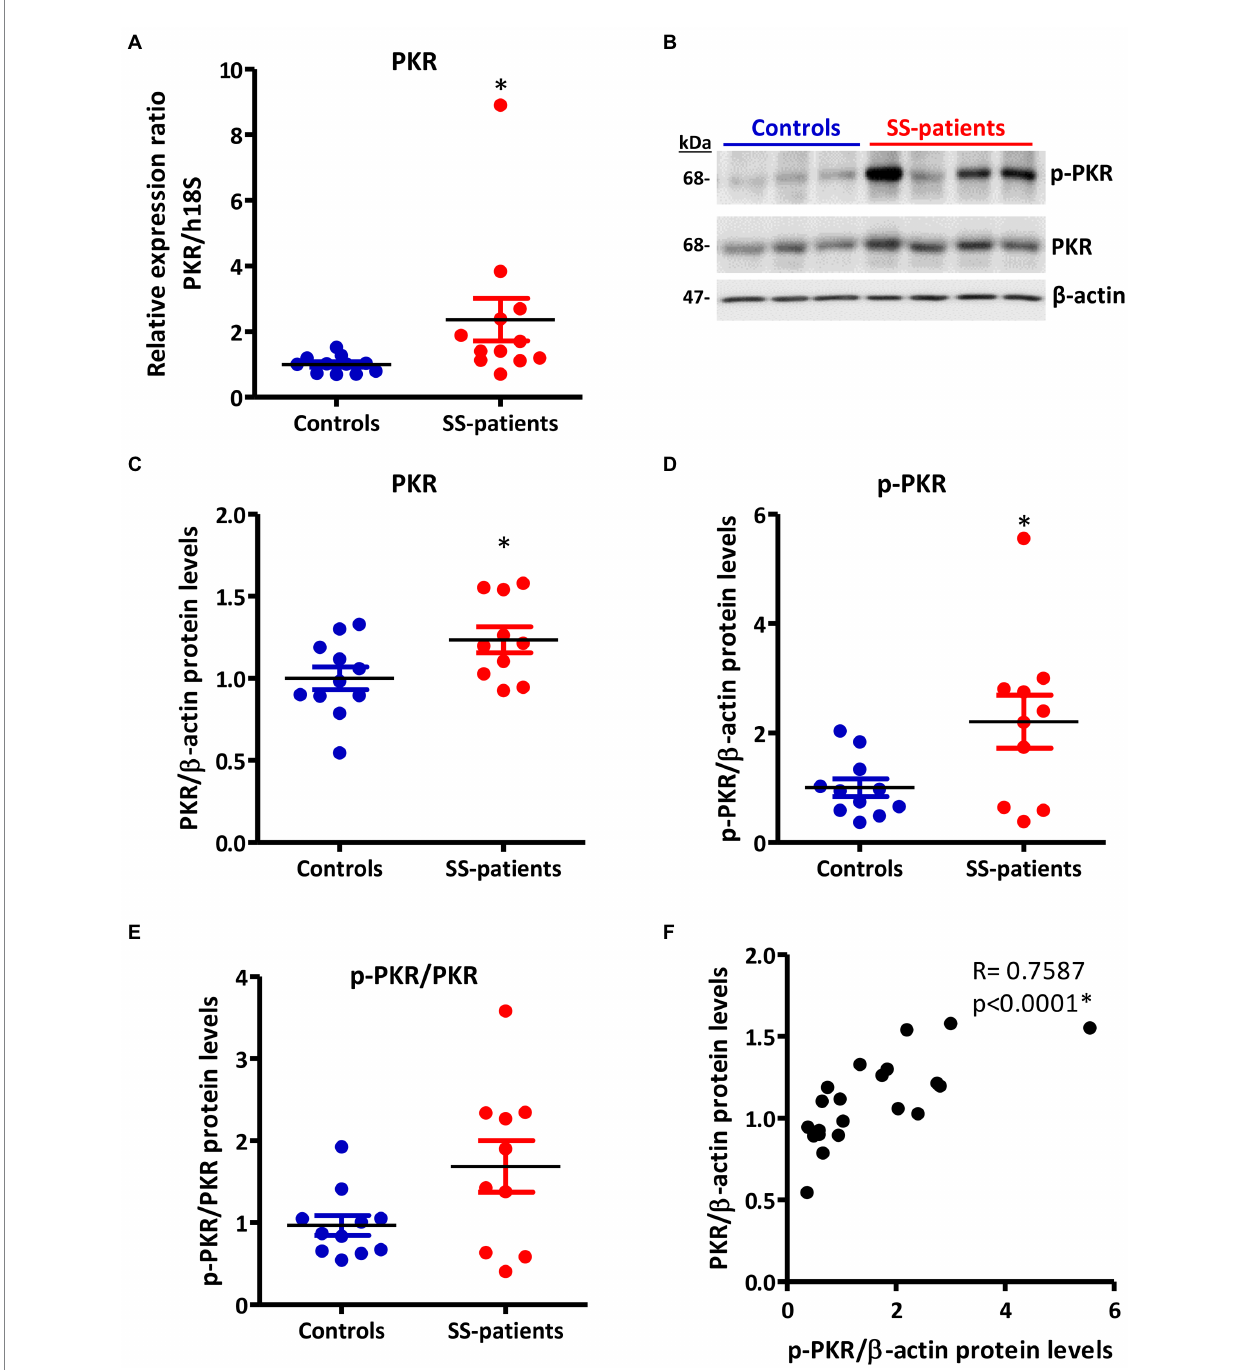
FIGURE 2 Expression and activation of PKR in LSGs from controls and SS-patients. (A) Dot plot showing PKR transcript levels relative to h18S in LSGs from controls (C) and SS-patients (P) ( n = 11C, 12P). (B) Representative images of PKR and p-PKR immunoblots from controls and SS-patients using β -actin as a loading control. (C) Dot plot showing densitometric analysis of PKR ( n = 11C, 10P). (D) Dot plot showing densitometric analysis of p-PKR ( n = 11C, 10P). (E) Dot plot showing the p-PKR/PKR ratio ( n = 11C, 10P). (F) Spearman’s correlation between p-PKR and PKR protein levels. These experiments were repeated at least three times (*). p values lower than 0.05 were considered